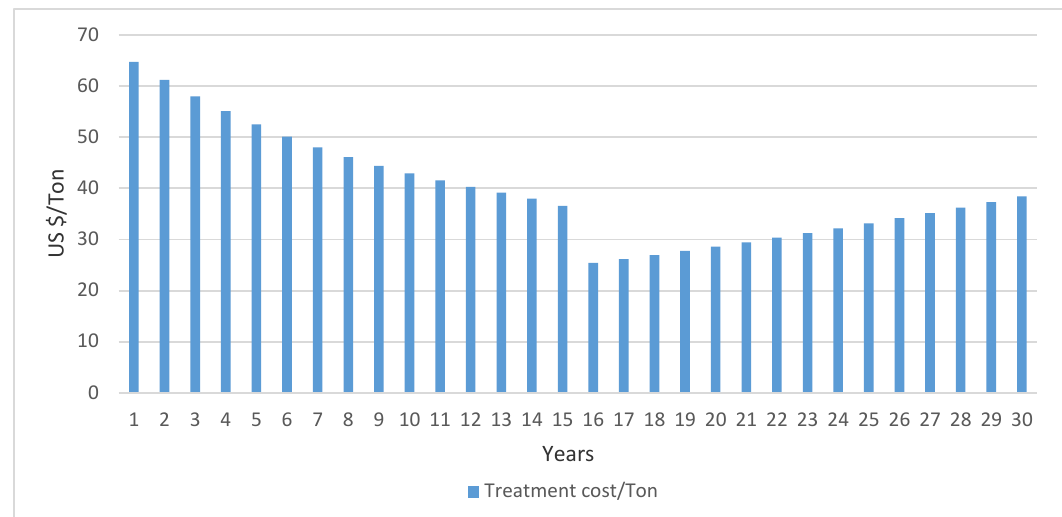
Figure 10. Annual distribution of treatment cost for each ton of MSW.